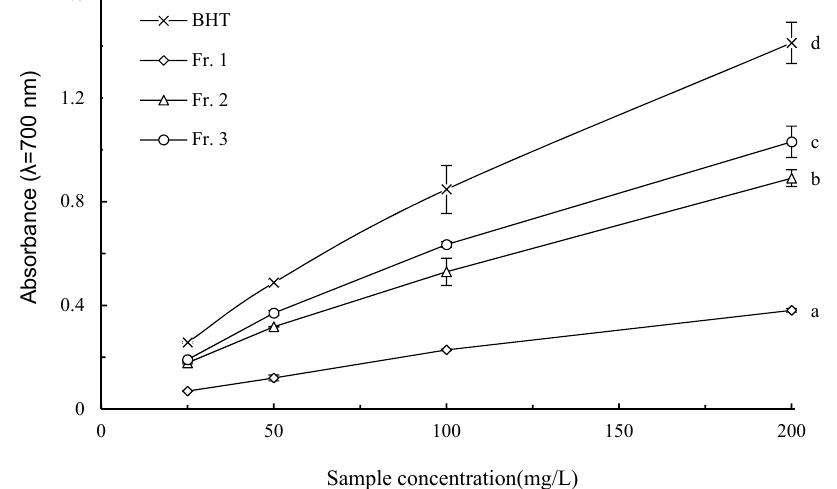
Figure 4. Dose dependent reducing power of pigment fractions from chestnut shells. The lower case letters on the right of the curves indicate significant differences between means at sample concentration of 200 mg/L ( p < 0.05).